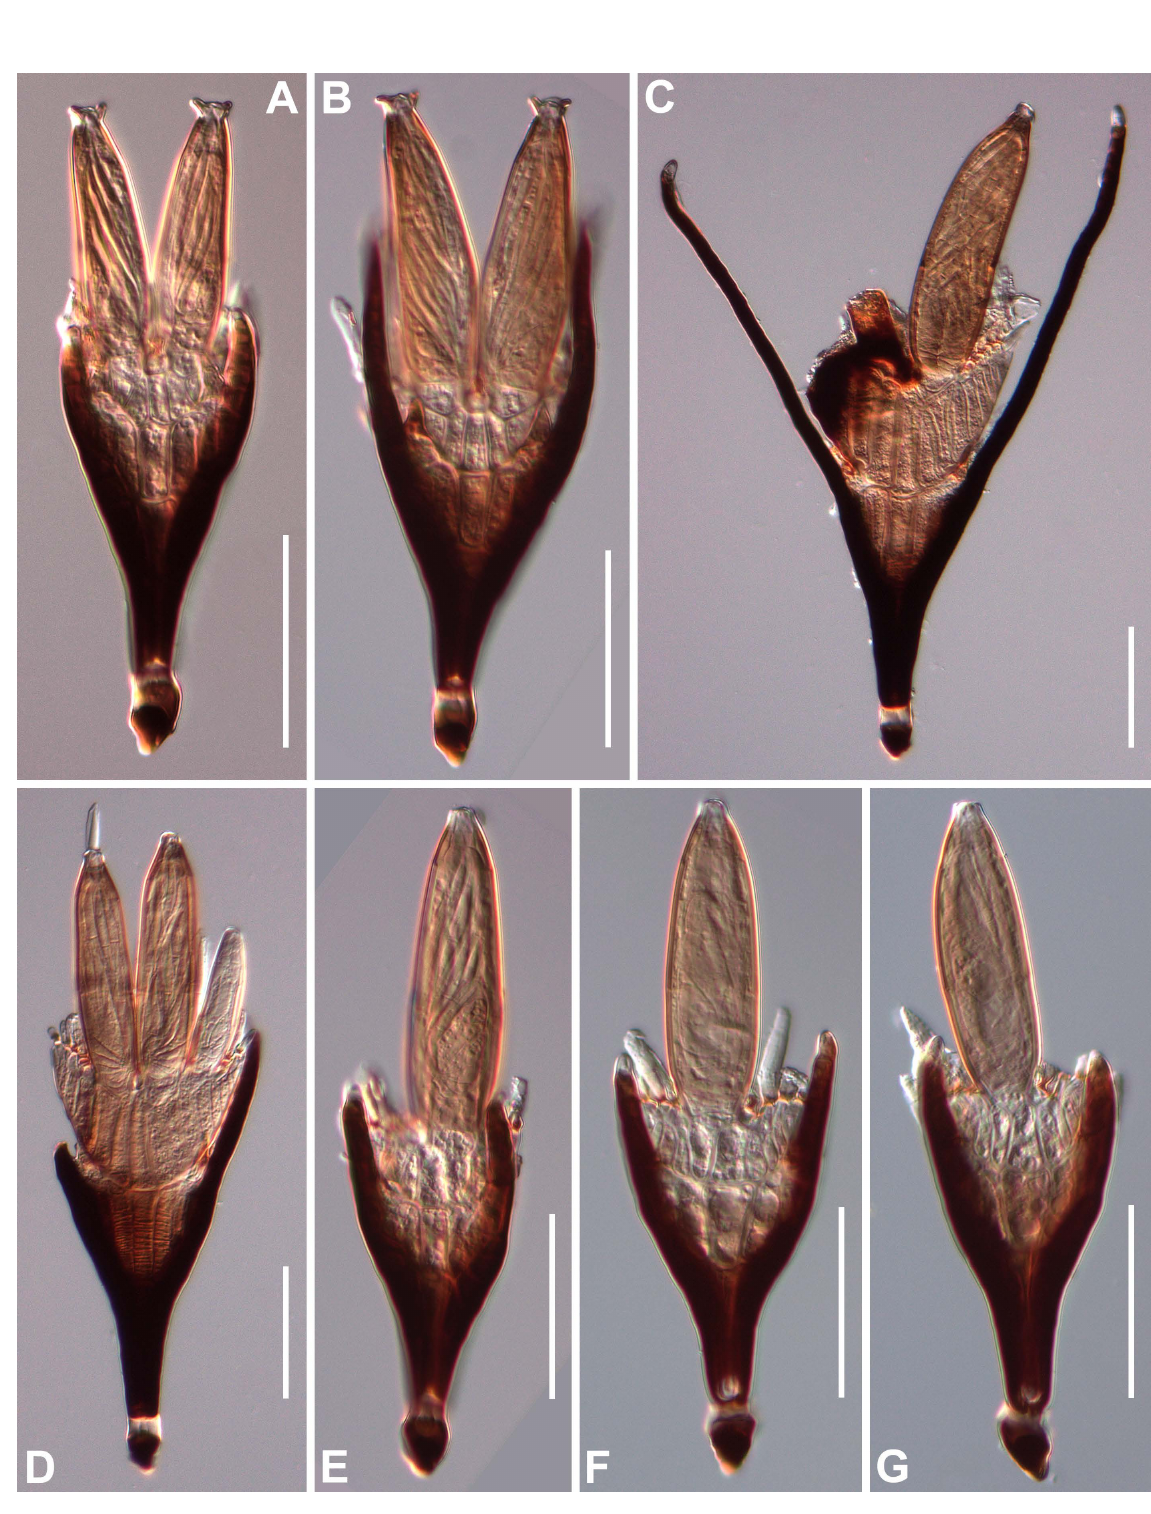
Fig. 67. Peyritschiella spp. A – B . P. furcifera (Thaxt.) I.I.Tav. Mature thalli. – C – D . P. hybrida (Thaxt.) I.I.Tav. Mature thalli. – E – G . P. nigrescens Thaxt. Mature thalli . Scale bars: 50 µm. Photographs from slides ZMUC C-F-122619 (A), ZMUC C-F-123314 (B), ZMUC C-F-123464 (C–D), ZMUC C-F-123314 (E), ZMUC C-F-123603